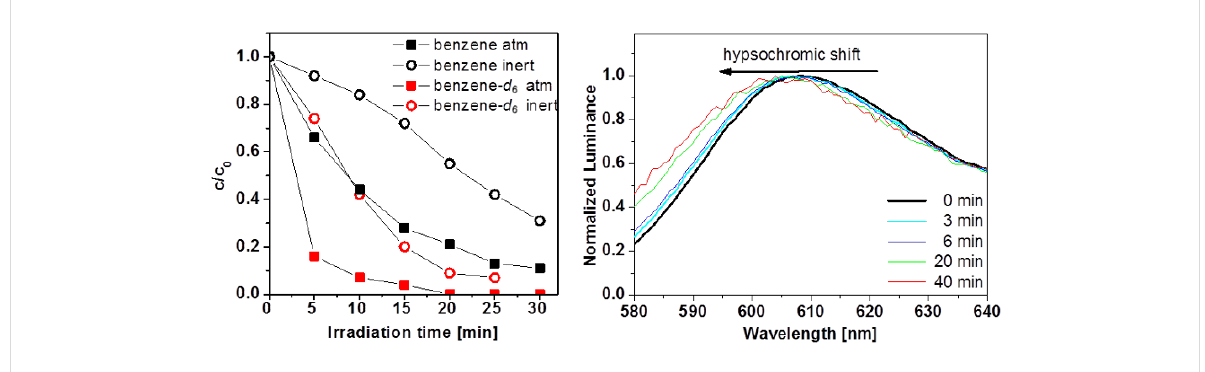
Figure 5: Degradation curves of Ir(piq) 3 in benzene and benzene- d 6 under ambient and inert conditions (left). Hypsochromic shift of the phosphores- cence of an Ir(piq) 3 -doped PMMA film with increased irradiation time (right).